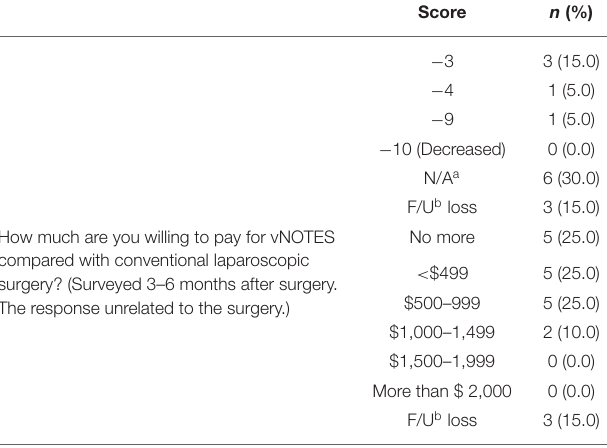
TABLE 4 | Summary of the survey after vNOTES ( n = 20). How worried are you about scarring from “vNOTES” surgery? (Surveyed before surgery)